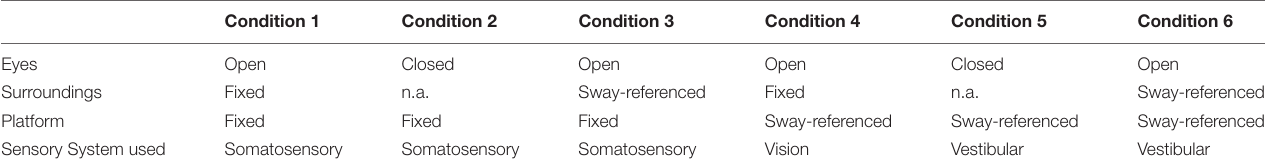
TABLE 1 | The six conditions of the Sensory Organization Test [Adapted from Instructions for Use: EQUITEST R (cid:13) SYSTEM OPERATOR’S MANUAL, Clackamas, OR (United States): NeuroCom R (cid:13) International Inc.,